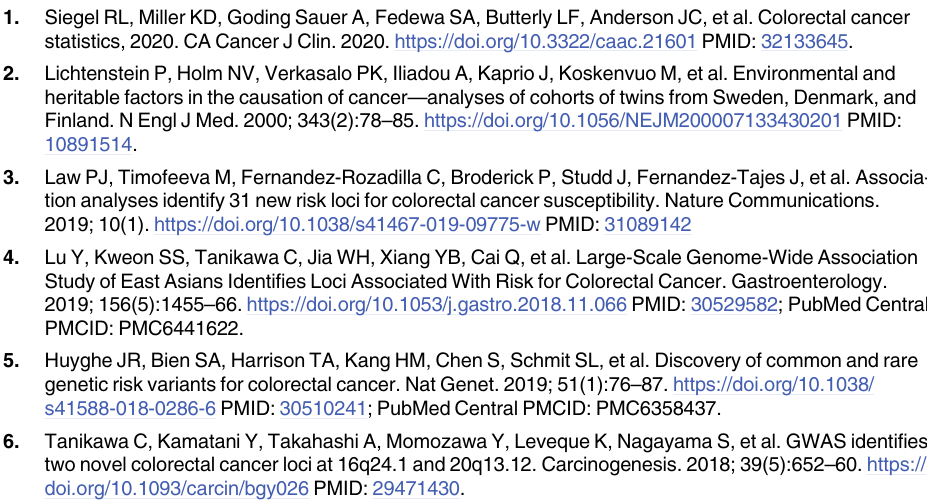
S6 Table. Correlation analysis between LIPG expression and clinicopathological character- istics of colorectal cancer. S7 Table. Primers or sgRNA sequence used in this